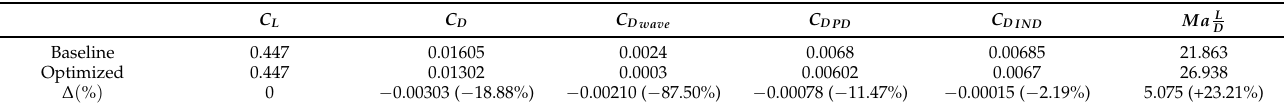
Table 9. Comparison of airfoil aerodynamic